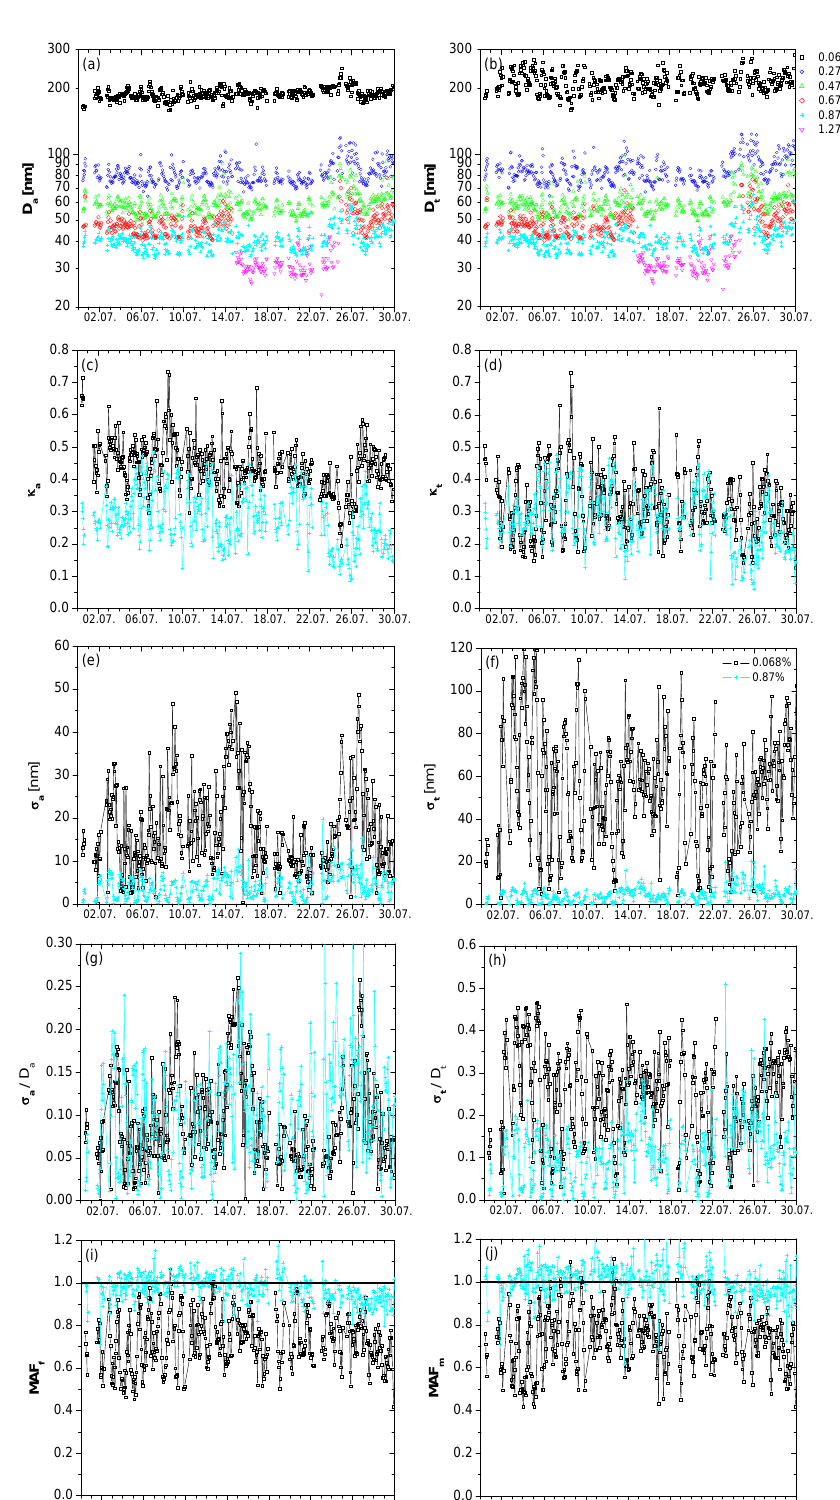
Fig. 5. Time series of the characteristic parameters derived from the CCN efficiency spectra measured at different supersaturations plotted against the date in July